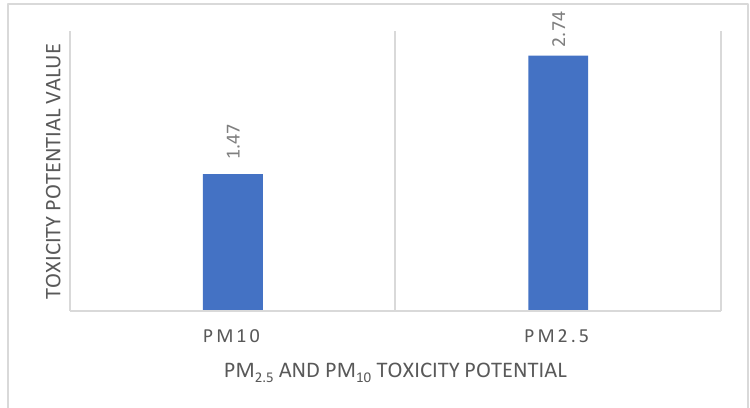
Figure 2. The PM 10 and PM 2.5 Toxicity Potentials.